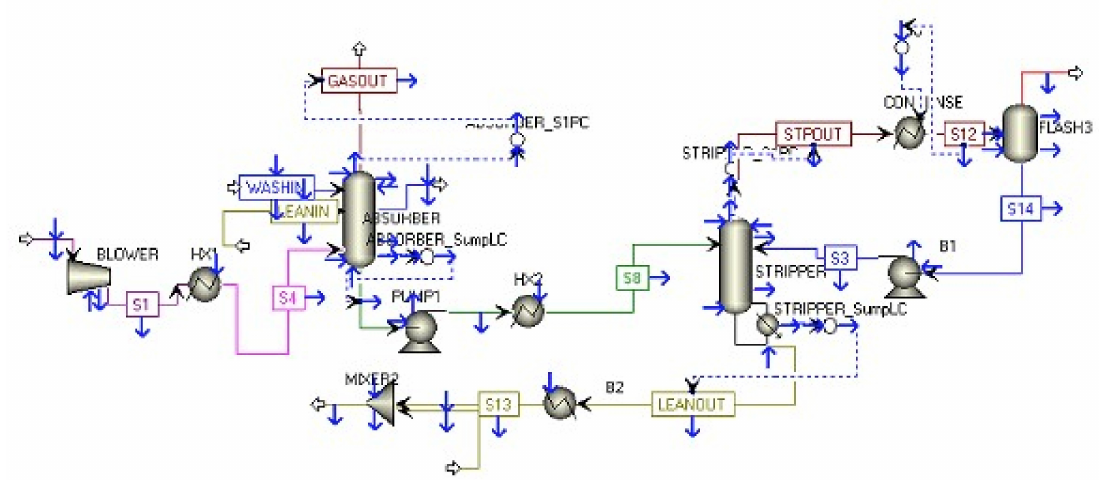
Figure A6. Flowsheet variable selection for control of around 492